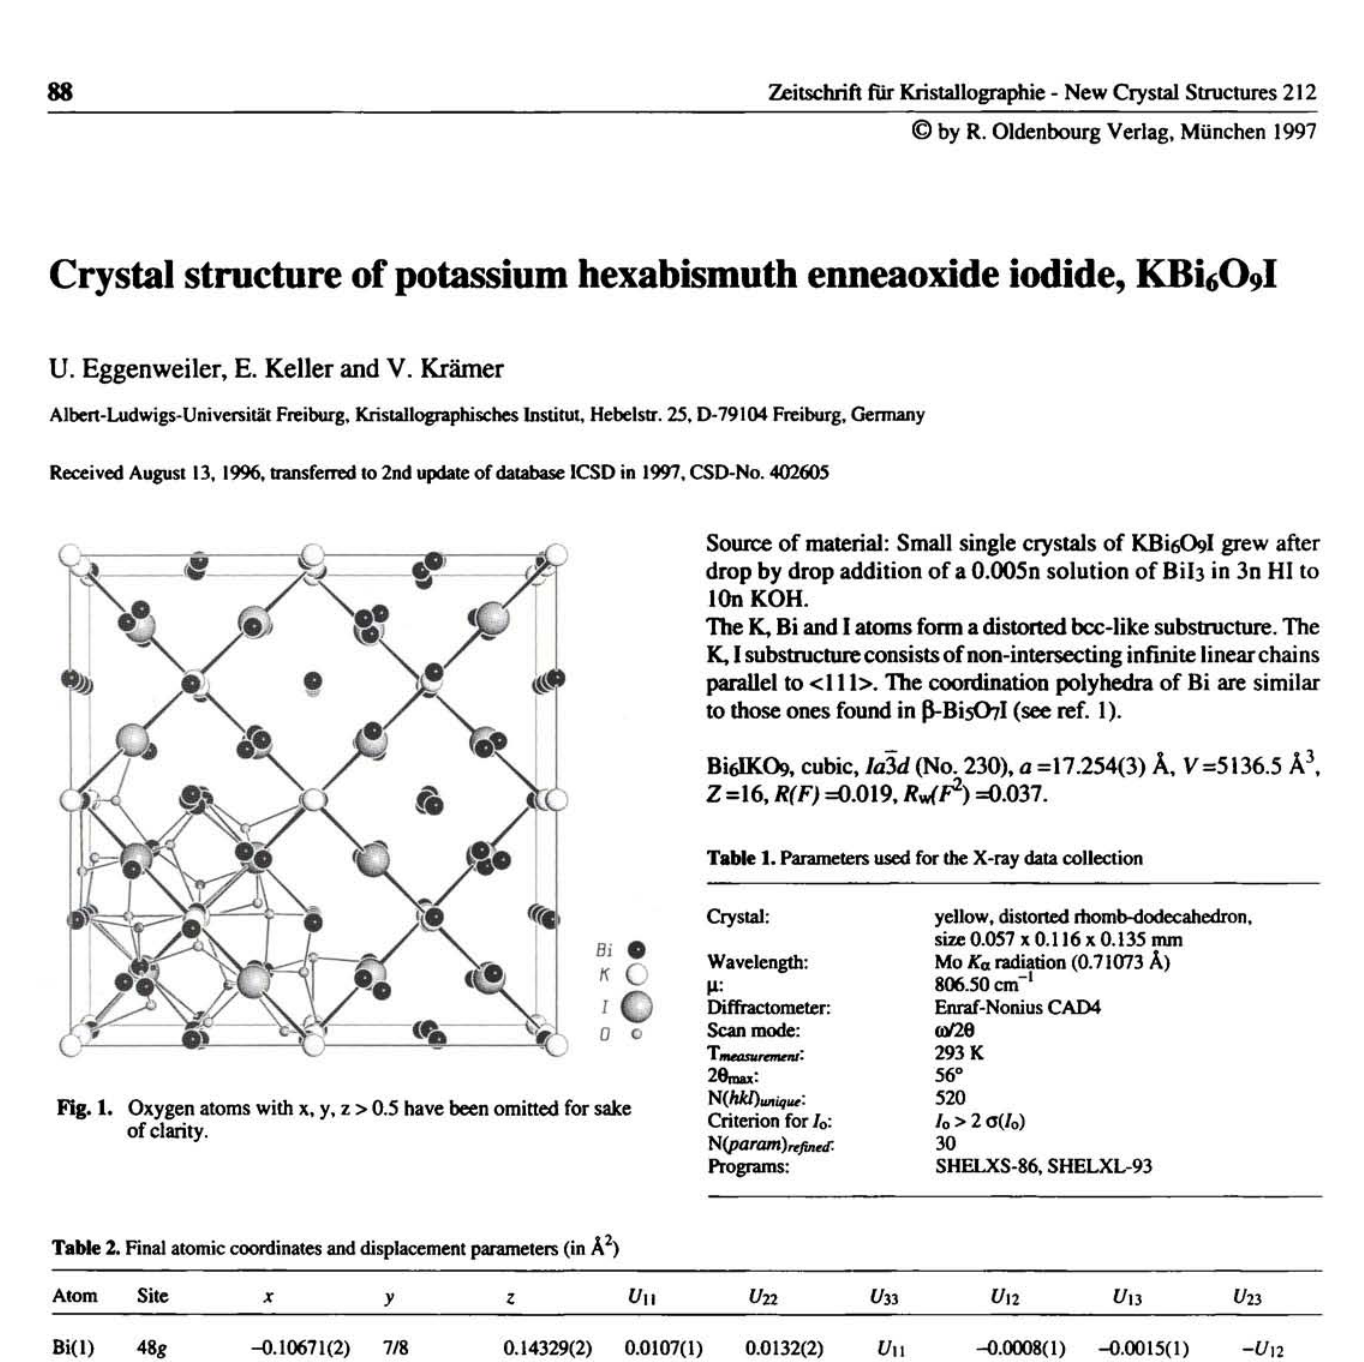
Table 2. Final atomic coordinates and displacement parameters (in Â 2